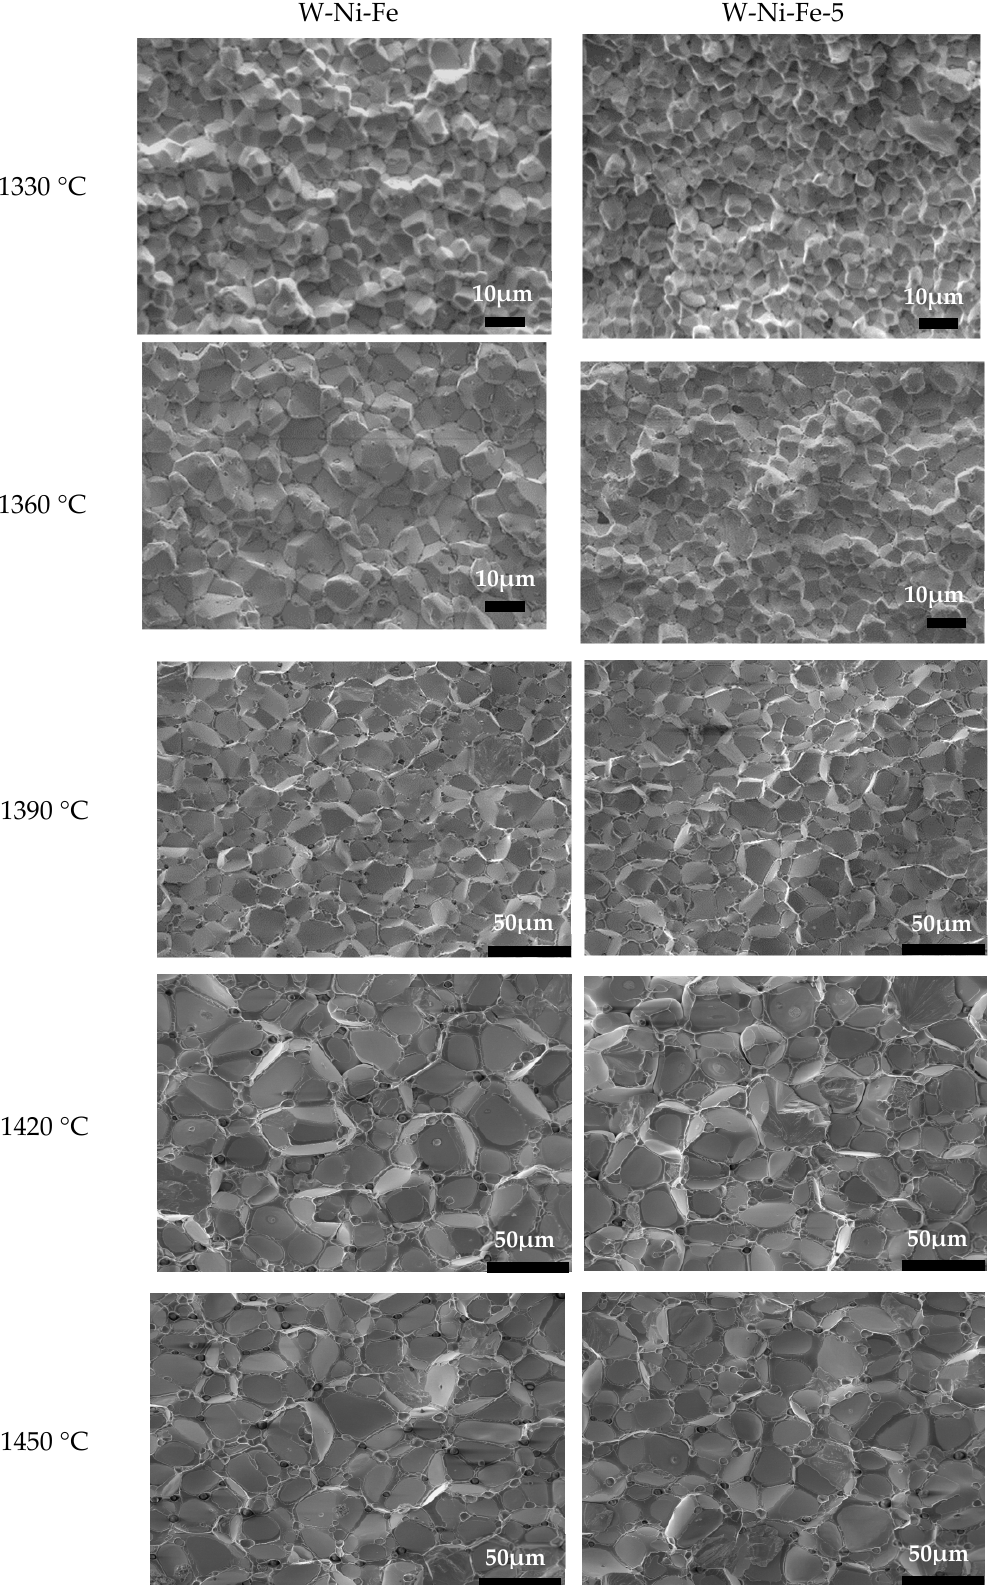
Figure 9. Fracture microstructure morphologies.